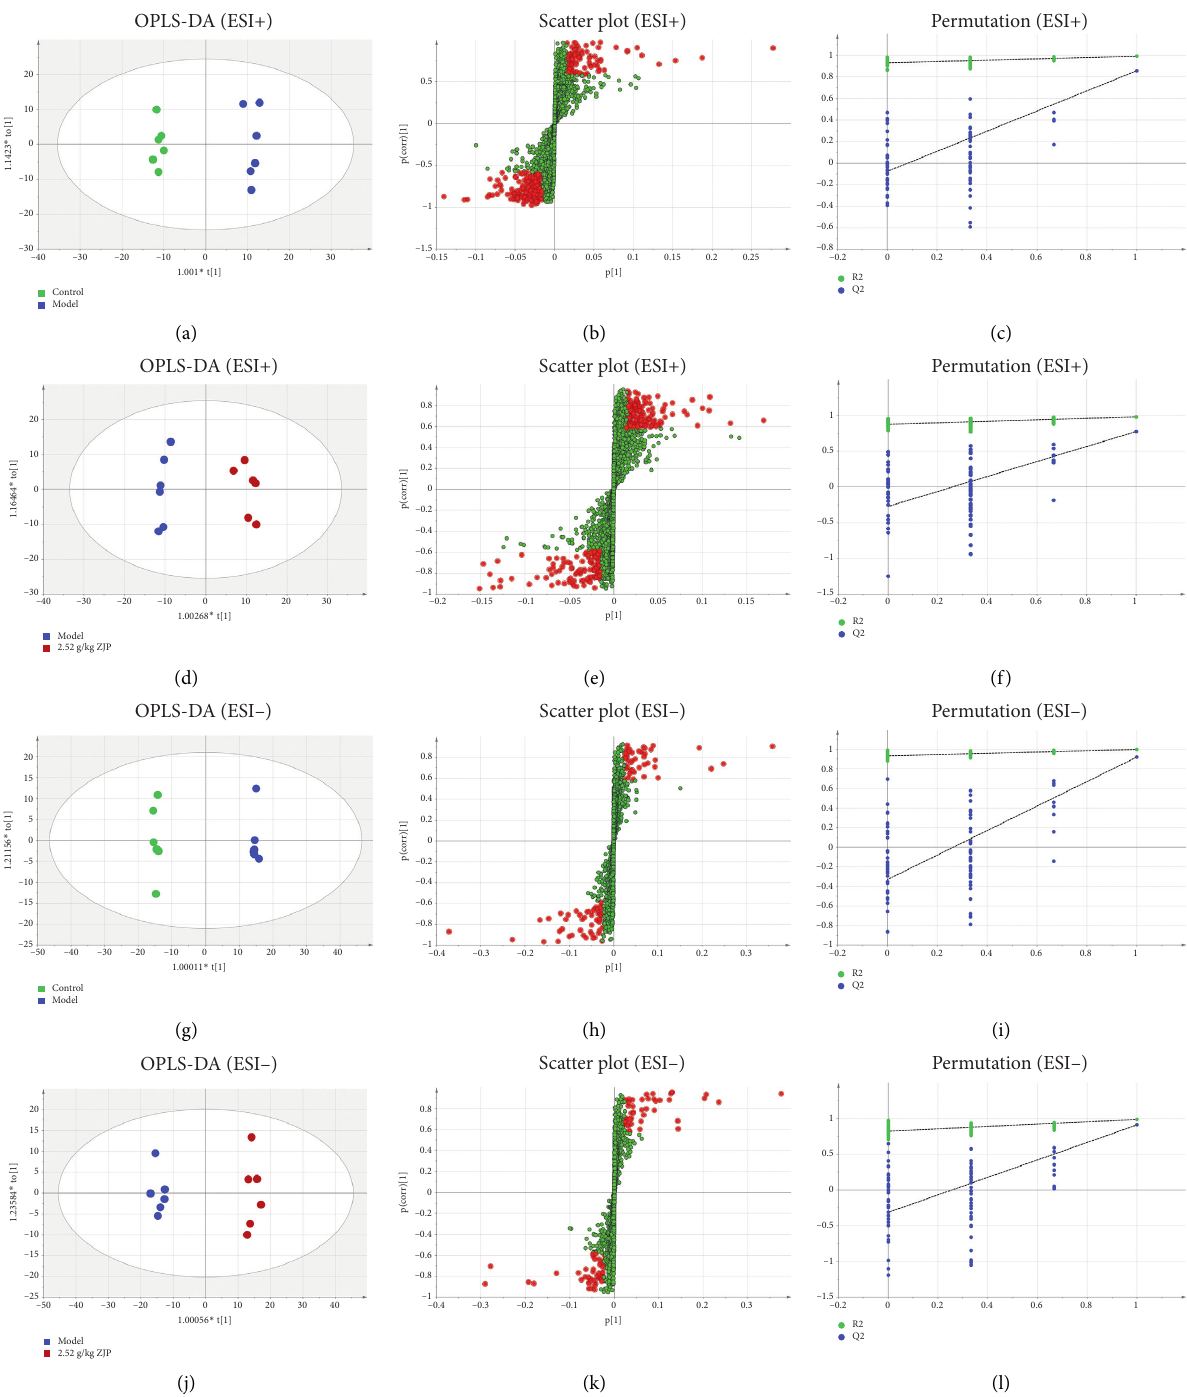
Figure 5: The OPLS-DA score plots, S-plot, and 100-permutation test generated of urine samples between the control group, model group, and 2.52g/kg ZJP group. OPLS-DA score plots were the pairwise comparisons in ESI+ mode, (a) control group versus model group and (d) model group versus 2.52g/kg ZJP group, as well as in ESI − mode, (g) control group versus model group and (j) model group versus 2.52 g/kg ZJP group. S-plot of the OPLS-DA model in ESI+ mode, (b) control group versus model group and (e) model group versus 2.52g/kg ZJP group as well as in ESI − mode, (h) control group versus model group and (k) model group versus 2.52g/kg ZJP group. The 100-permutation test of the OPLS-DA model in ESI+ mode, (c) control group versus model group and (f) model group versus 2.52g/kg ZJP group as well as in ESI − mode, (i) control group versus model group and (l) model group versus 2.52g/kg ZJP